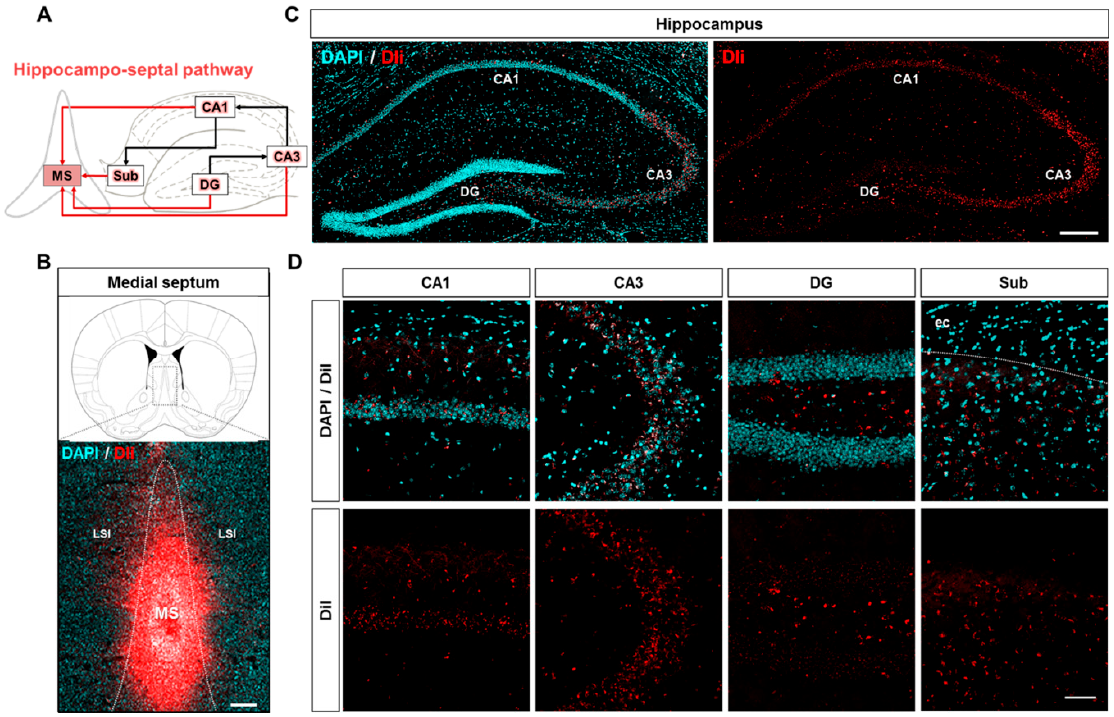
Figure 4. Profiling of the hippocampo-septal pathway with the retrograde neuronal tracer DiI. ( A ) Schematic of the hippocampo-septal pathway. Red arrows indicate the afferent projections from the hippocampal formation to the MS. Black arrows indicate the indirect afferent projections from the hippocampal formation to the MS. ( B ) Verification of the MS coordinates by stereotaxic injection of the retrograde tracer DiI. Scale bar = 200 μ m. ( C ) Visualization of DiI fluorescence retrogradely transported from the MS to the hippocampus. Scale bar = 200 μ m. ( D ) Magnified images represent DiI-positive somata in the subregions of the hippocampal formation. DAPI was used to counterstain the nuclei. Scale bar = 100 μ m.